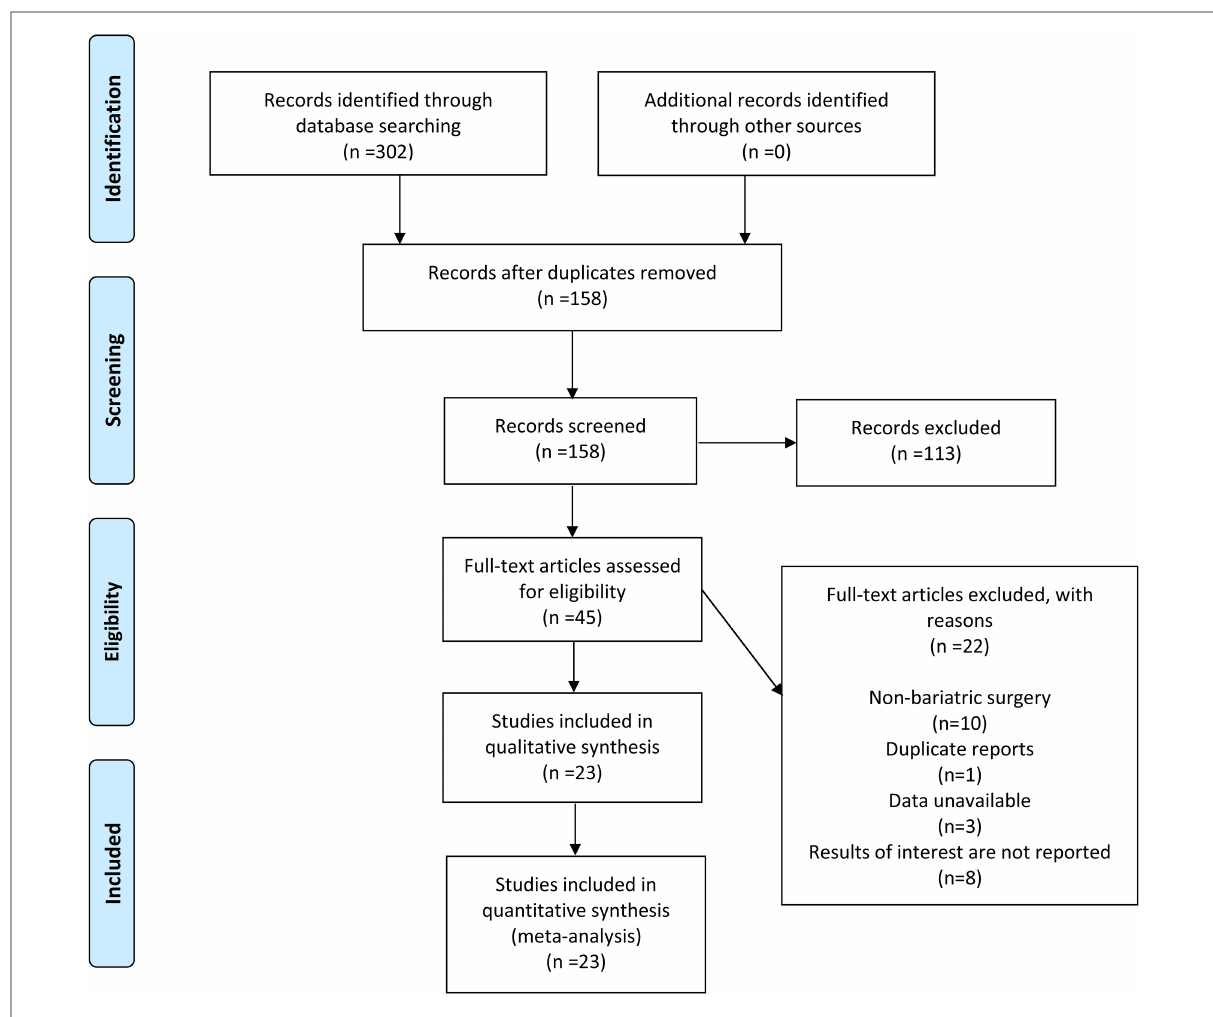
FIGURE 1 Flow chart for the selection of studies included in the